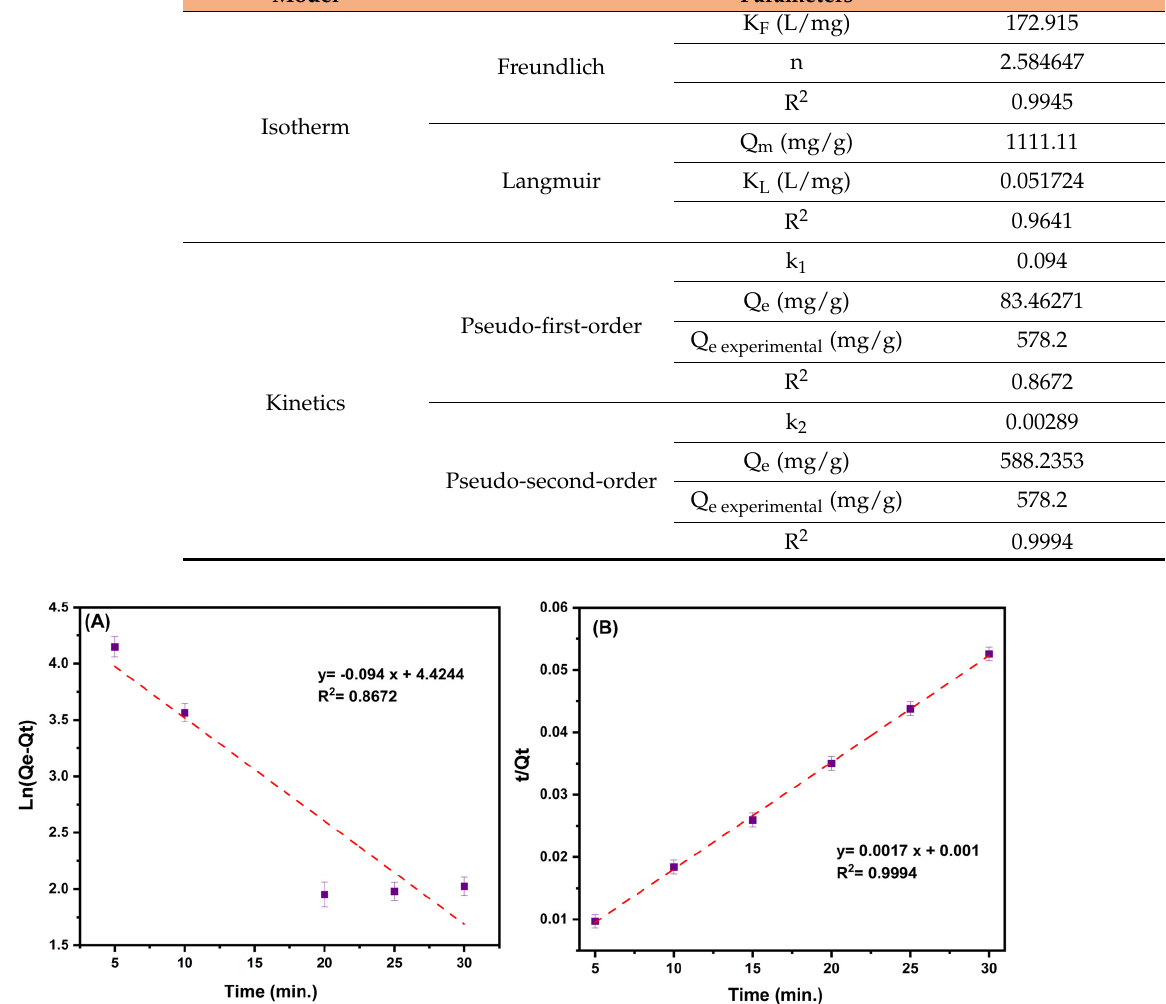
Figure 9. ( A ) The plot of the Ln of (equilibrium adsorption capacity (Q e , mg/g) minus adsorption capacity at time t (Q t , mg/g)) to time (min.) [Pseudo-first-order kinetic]. ( B ) The plot of the ratio of time (min)/adsorption capacity at time t (Q t , mg/g) to time (min.) [Pseudo-second-order kinetic]. Conditions: contact time (5–30 min), pH:7, MMIP dosage (3 mg), ciprofloxacin initial concentration (200 mg/L) and T (298